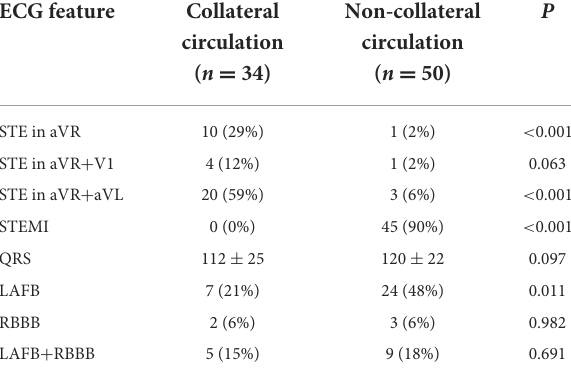
TABLE 2 Relation between ECG patterns and collateral circulation in LM occlusion. ECG